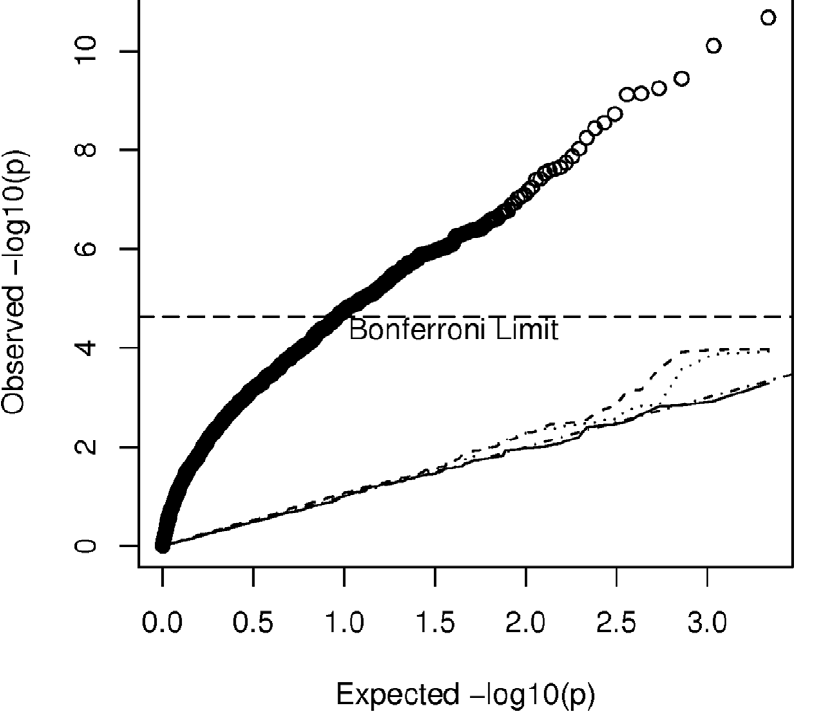
Figure 6. Quantile-quantile plot of p-values from association tests in the hypothesized case-control study in which cases from the CBCS and controls from the MEC are used. The plotted values indicate adjustment for 0 (uncorrected heavy solid line), 1 (dashed line), 10 (dotted line) and 200 (thin solid line) eigenvectors, by using these components in the calculation of K _ .